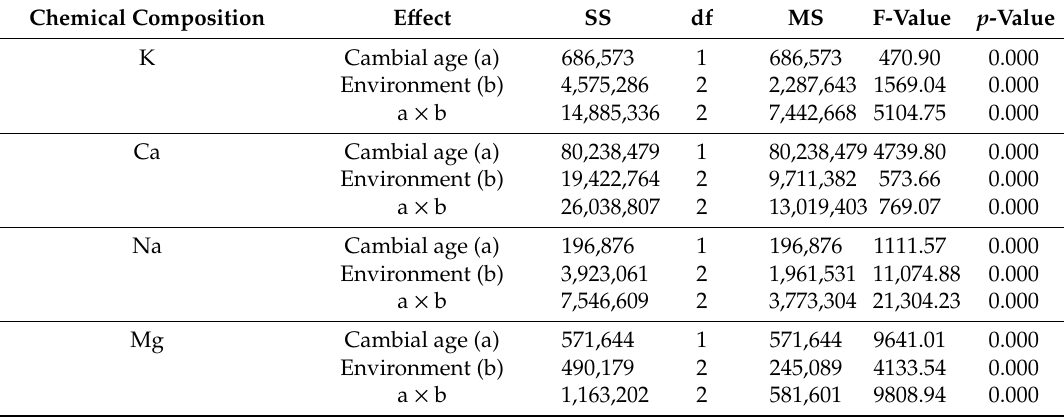
Table 5. Two-factor ANOVA tables for chemical composition of elements (K, Ca, Na, Mg) of lime ( Tilia cordata Mill.) taking into account the e ff ect of cambial age and environment.